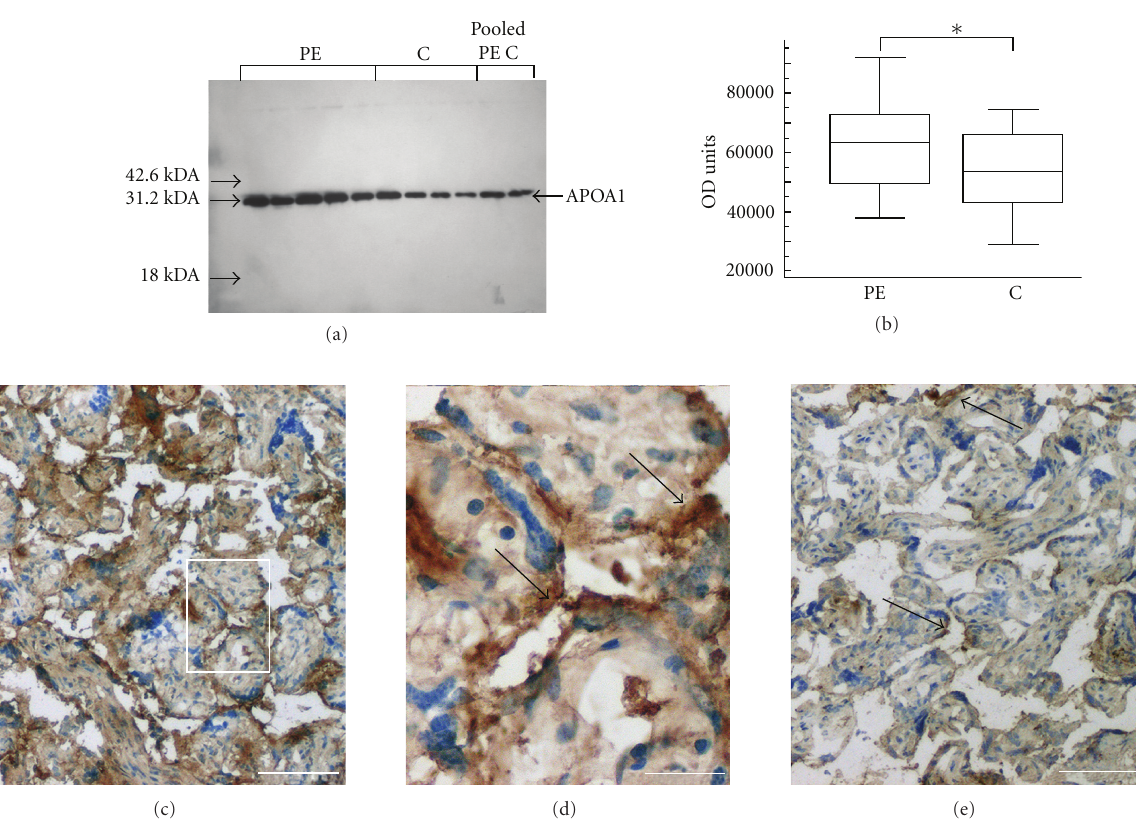
Figure 5: Validation of APOA1 accumulation. (a) A representative scanned image of Western blots for APOA1 (PE: n = 5 and C: n = 4). All individual sample extracts were run (PE: n = 30 and C: n = 30). Expected size for APOA1 is 28kDA. Molecular weight markers are represented by arrows. (b) Box plot for the intensity data for APOA1 as determined by GeneTools, showing the median and the 25th and 75th percentile. APOA1 was significantly increased in PE ( P = . 02) (PE: 62247 (56597–67897) OD units, C: 53551 (48354–58749) OD units. Both values are presented as mean (95th percentile confidence interval). (c) Representative image for immunohistochemistry on APOA1 on a PE section. Scale bar = 100 μ m. (d) Zoomed in image of APOA1 staining in a PE section (from the box in D). APOA1 staining was detected in trophoblasts (arrow). Scale bar = 30 μ m. (e) A representative image of a control section. APOA1 staining was weaker than in PE but was localized in trophoblasts as seen in PE. Scale bar = 100 μ